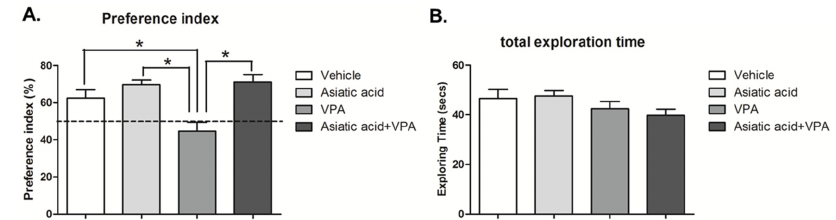
Figure 1. Mean exploration times of the animals exploring each object during the familiarization ( A ) ( A ) and choice ( B ) trials of the novel object location test after treatment. There were no significant differences in the exploration times of either object for any group in the familiarization (* p > 0.05). In the choice trial, vehicle, Asiatic and Valproic acid (VPA) plus Asiatic acid groups spent a significantly longer time exploring the object in the novel location compared with the familiar location ( p < 0.05), whereas the VPA group failed to discriminate between objects ( p >